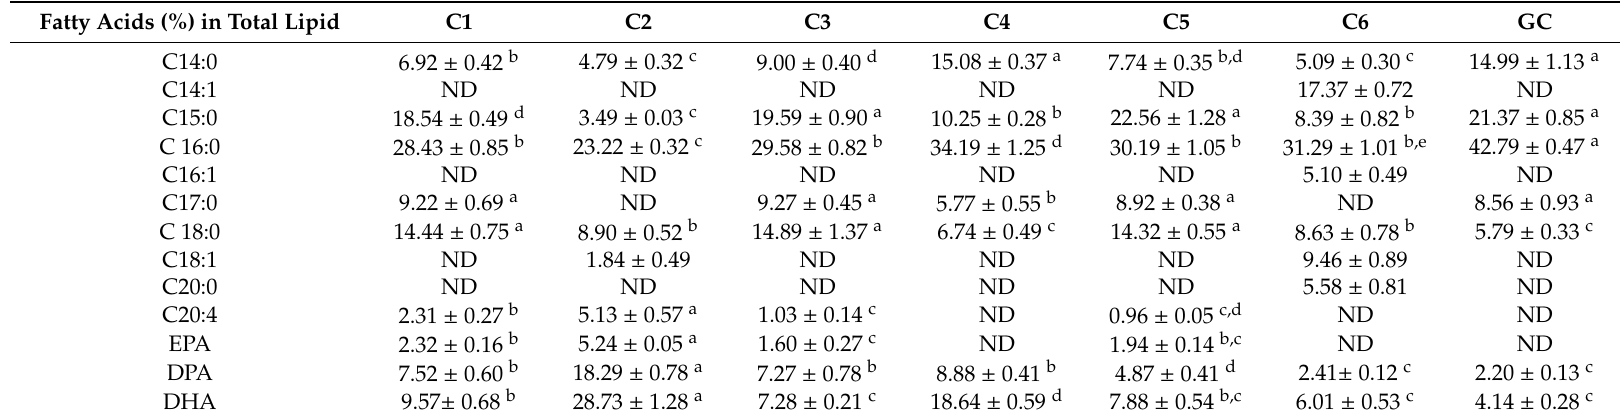
Table 2. Fatty acid composition (wt% of total fatty acids) of Aurantiochytrium sp. T66 cultivated on 10 g / L of various VFAs (C1:0, formic acid; C2:0, acetic acid; C3:0, propionic acid; C4:0, butyric acid; C5:0, valeric acid and C6:0, caproic acid). Glucose (GC) was used as control. Fatty Acids (%) in Total